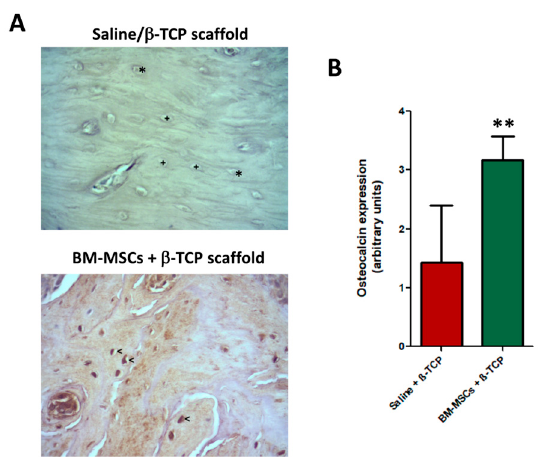
Figure 6. Representative images of immunohistochemical expression of osteocalcin of maxillary bone